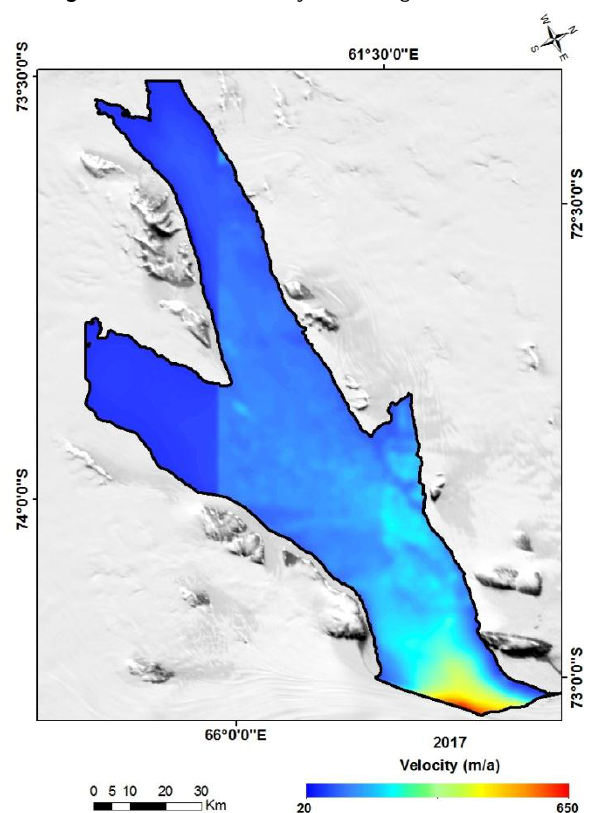
Figure 7: Estimated velocity of Fisher glacier in